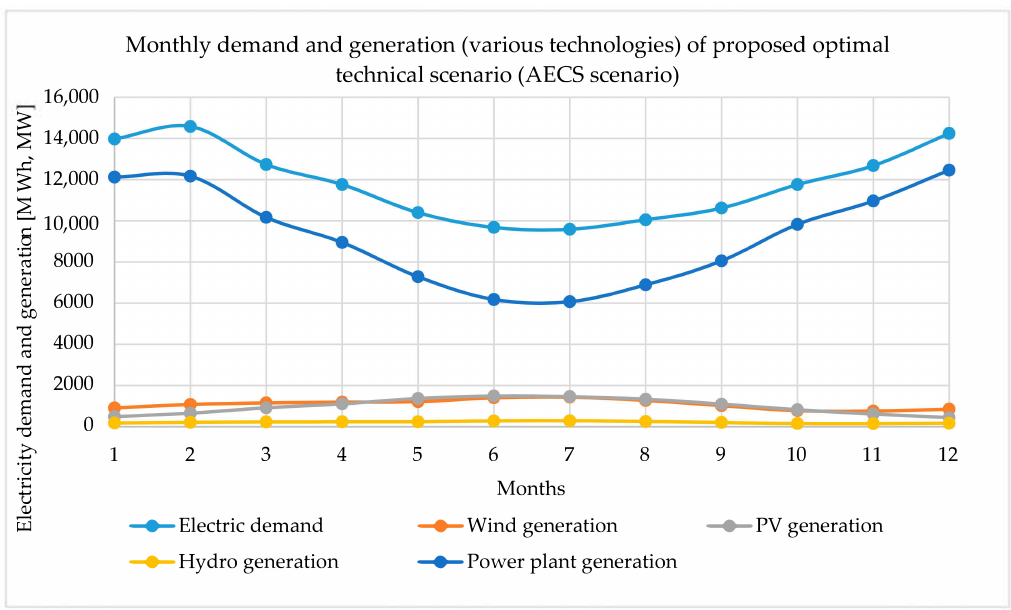
Figure 12. Monthly demand and generation of the proposed optimal technical scenario (AECS scenario).